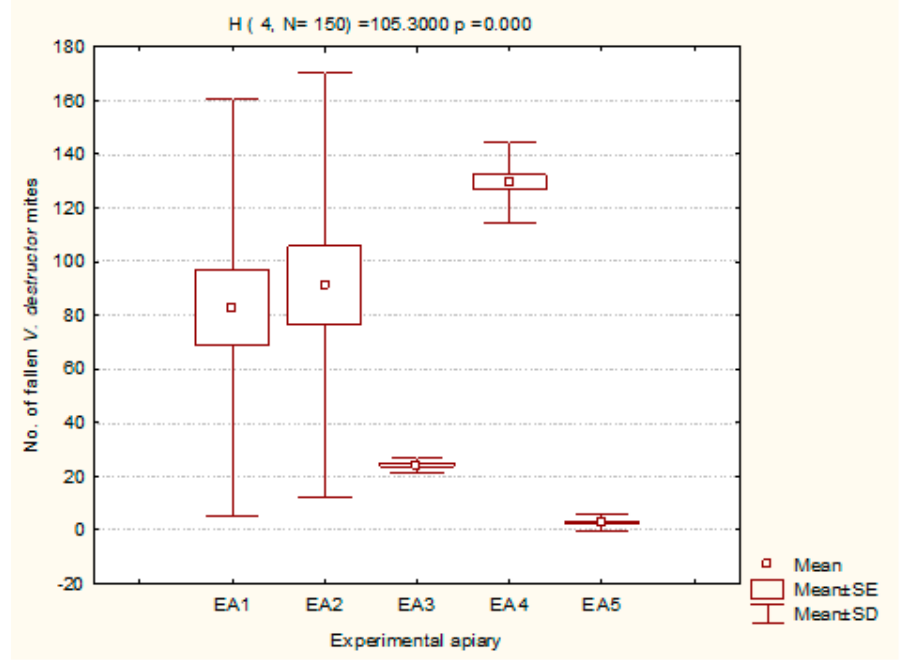
Figure 3. Natural V. destructor mite drop during the pretreatment period at five apiary locations (EA1– EA5).